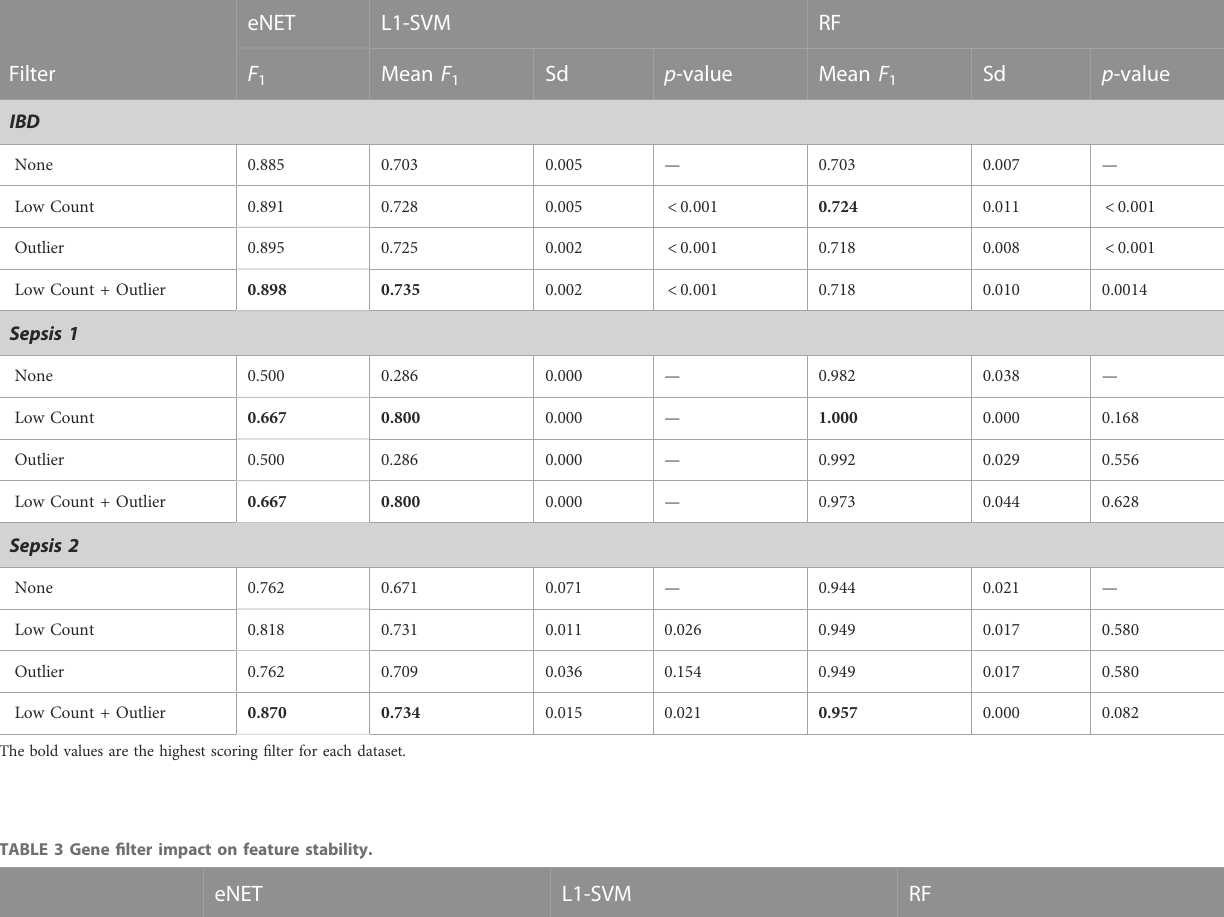
TABLE 3 Gene fi lter impact on feature stability.